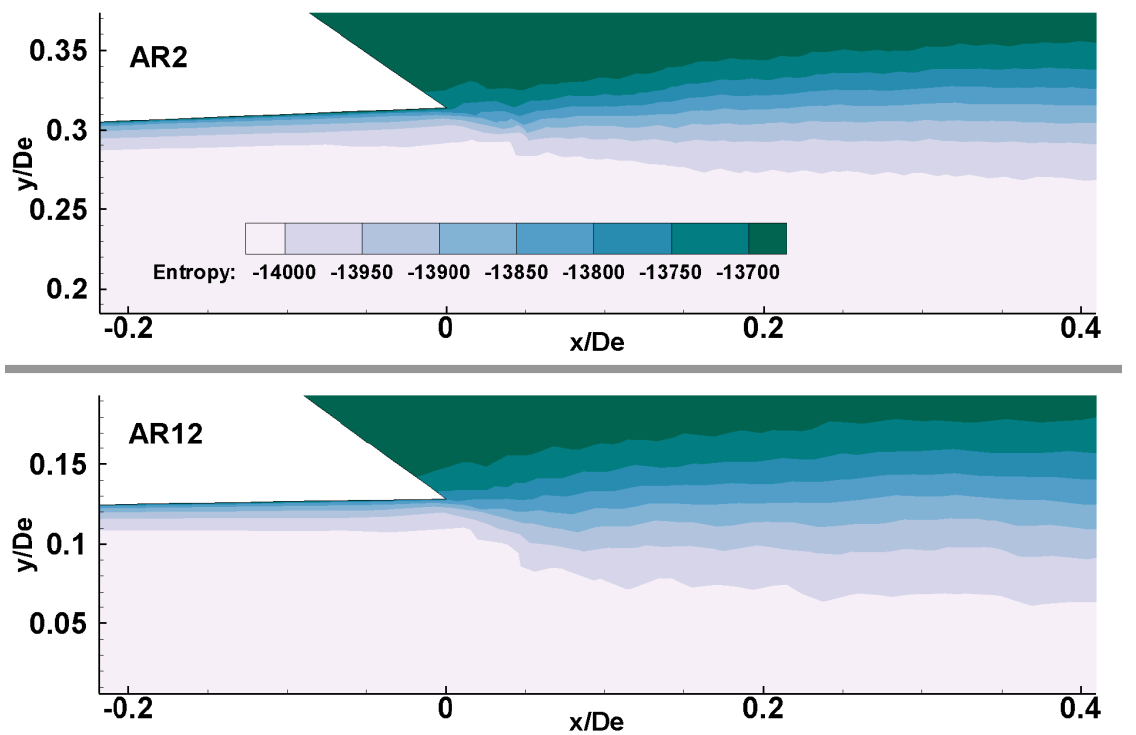
Figure 8. Contours of entropy J/(kg · K) zoomed in at nozzle exit in AR2 and AR12 nozzle on minor axis symmetry Figure 8 . Contours of entropy J/(kg·K) zoomed in at nozzle exit in AR2 and AR12 nozzle on minor axis symmetry plane.